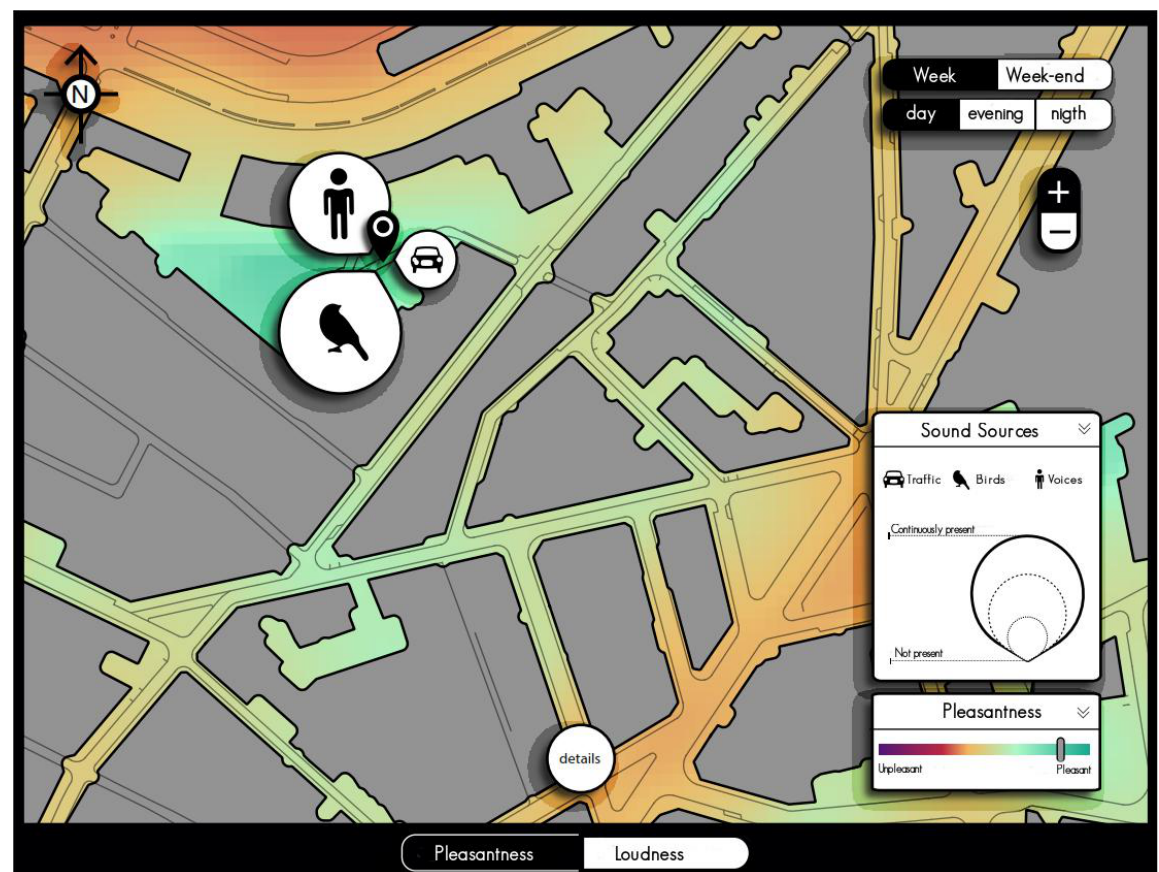
Figure 19: Final representation of the sound quality with visualization of sound source presence and visualization of the period of the se- lected map (buttons in